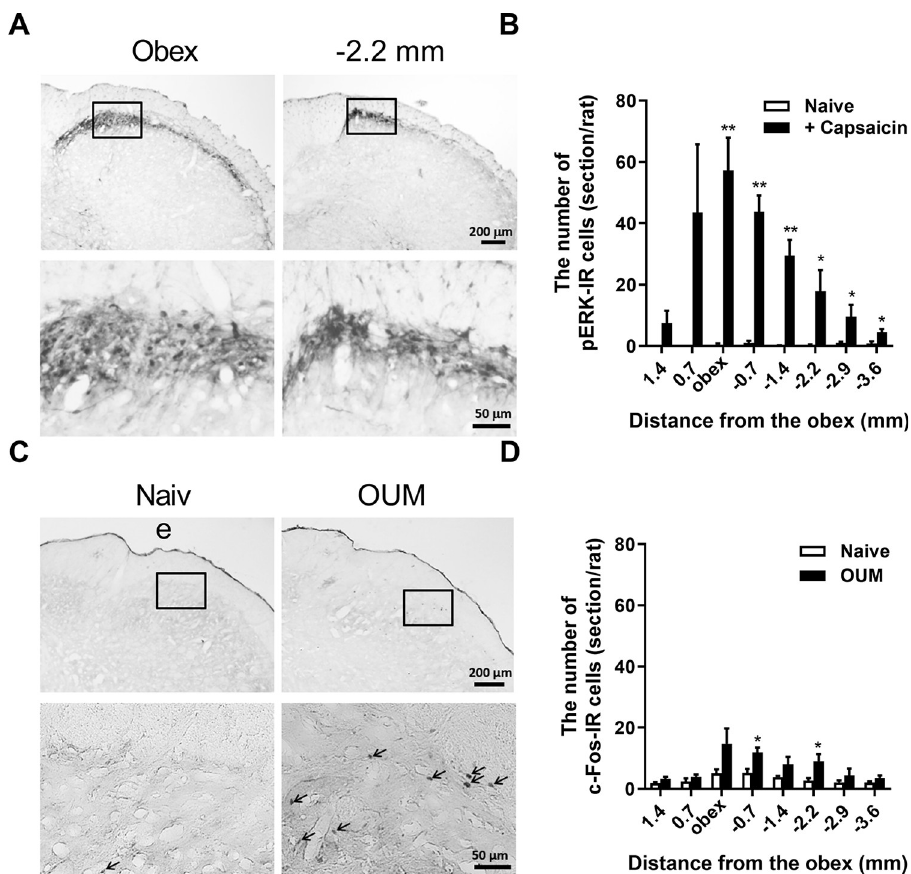
Fig 5. Expression of pERK1/2- and c-Fos-immunoreactive (IR) cells in trigeminal spinal subnucleus interpolaris/ caudalis (Vi/Vc). (A) Representative photomicrographs of pERK1/2-IR cells in Vi/Vc at obex and -2.2 mm from obex following capsaicin application for 1 min to the oral mucosa in labial fornix region of the inferior incisors. Scale bar, 200 μ m (Upper) and 50 μ m (Lower). Lower microphotographs are expanded views of the upper squares. (B) Rostro- caudal distribution of pERK1/2-IR cells in ipsilateral Vi/Vc following capsaicin application. * p < 0.05, ** p < 0.01 vs. Naive, Unpaired t -test (n = 4–5 in each group). (C) Representative photomicrographs of c-Fos-IR cells in Vi/Vc in Naive and OUM model on day 2 after acetic acid treatment in the oral mucosa labial fornix inferior region incisors. Scale bar, 200 μ m (Upper) and 50 μ m (Lower). Lower microphotographs are expanded views of the upper squares. (D) Rostro-caudal distribution of c-Fos-IR cells in ipsilateral Vi/Vc in Naive and OUM model. * p < 0.05 vs. Naive, Unpaired t -test (n = 5 in each group). results imply that OUM is an infectious inflammation. In this gene ontology analysis, upregu- lated genes in the TG of the OUM model were associated with functions of “Defense response,” “Response to wounding,” and “Inflammatory response.” These functions matched with OUM characterization, indicating changes in OUM-specific genes in the TG. Hepcidin is an anti-microbial peptide hormone (included in the defensin group) that regu- lates iron metabolism [33–35]. Most organisms require iron to survive, including oxygen transport by hemoglobin, cellular respiration, DNA synthesis, and reactive oxygen species (ROS) generation for host defense [35, 36]. Hepcidin is produced in hepatocytes with an increase in plasma iron concentration. It binds to an iron exporter, ferroportin (FPN), which is present on the surface of macrophages, endothelial cells, and neurons, decreasing the export of cellular iron via the degradation and internalization of FPN [32, 33]. Hepcidin is also expressed in the brain and regulates iron homeostasis [33]. During inflammation, an